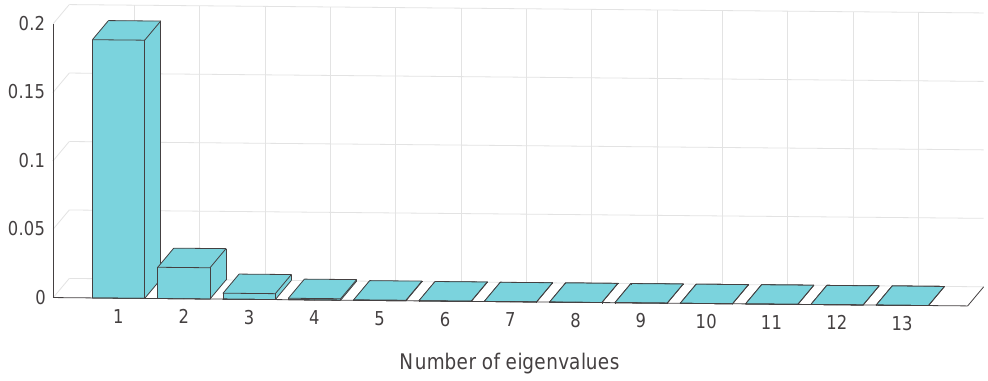
Figure 12. Eigenvalues by applying PCA to 13-dimensional MNPE